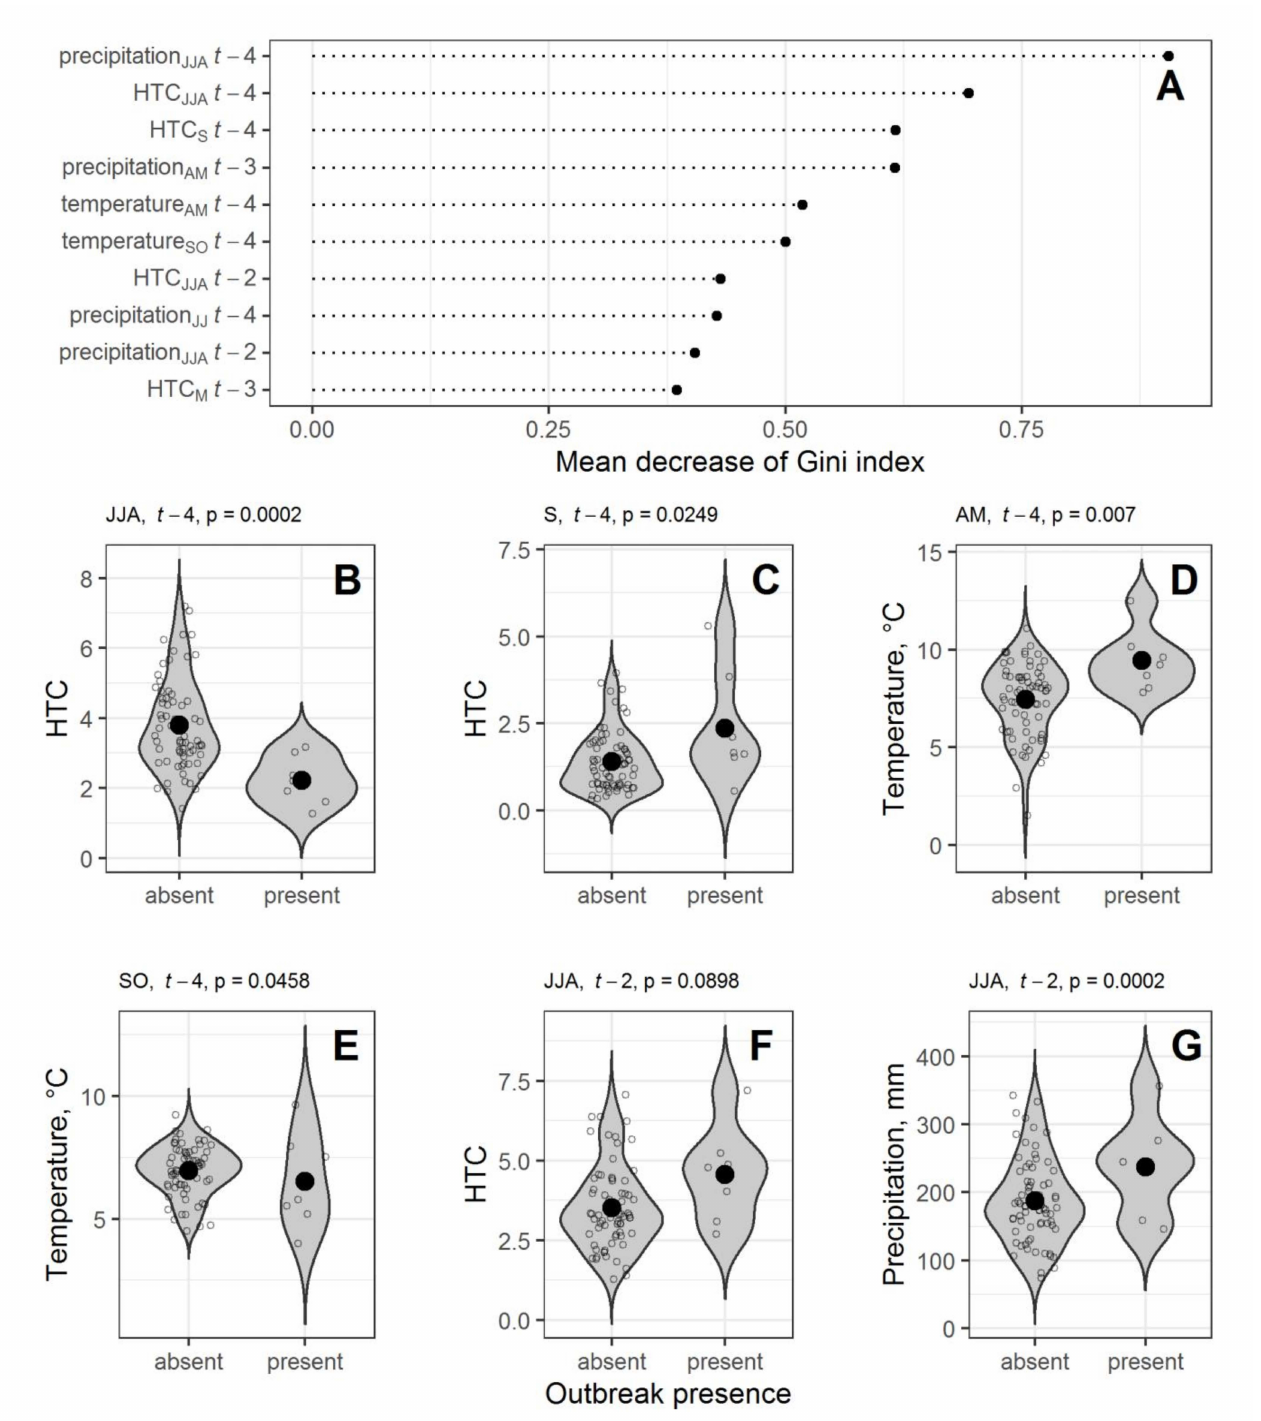
Figure 2. Results of selecting predictors for outbreaks of B . piniaria using the random forest ( A ) and log-linear analysis ( B – G ). ( B – G ) illustrations for each predictor: months (AM, April and May; JJA, June–August; S, September; SO, September and October), number of years before outbreak ( t − 2 and t − 4, consequently, two and four years before), and significance level of the predictor as determined by